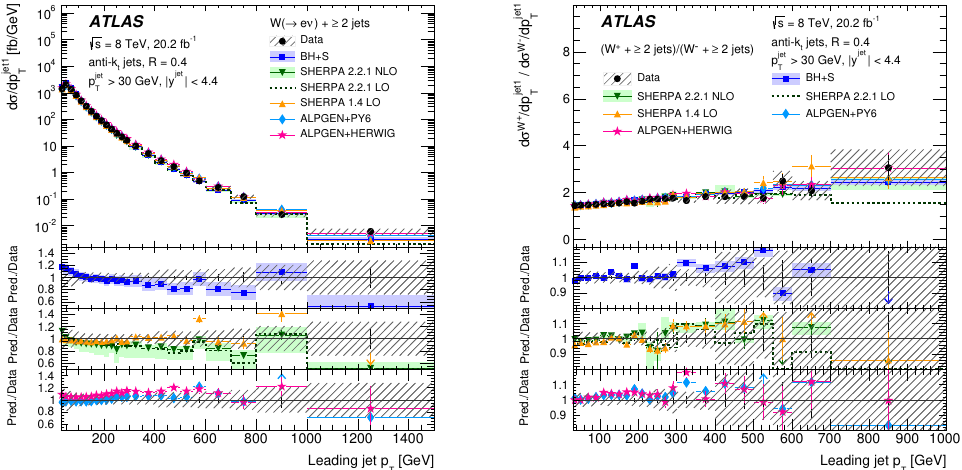
Figure 13 . Di(cid:11)erential cross sections for the production of W bosons (left) and the W + =W (cid:0) ratio (right) as a function of the leading jet p T for events with N jets (cid:21) 2. The last bin in the left (cid:12)gure includes values beyond the shown range. For the data, the statistical uncertainties are indicated as vertical bars, and the combined statistical and systematic uncertainties are shown by the hatched bands. The uppermost panel in each plot shows the di(cid:11)erential cross sections, while the lower panels show the ratios of the predictions to the data. The theoretical uncertainties on the predictions are described in the text. The arrows on the lower panels indicate points that are outside the displayed range.